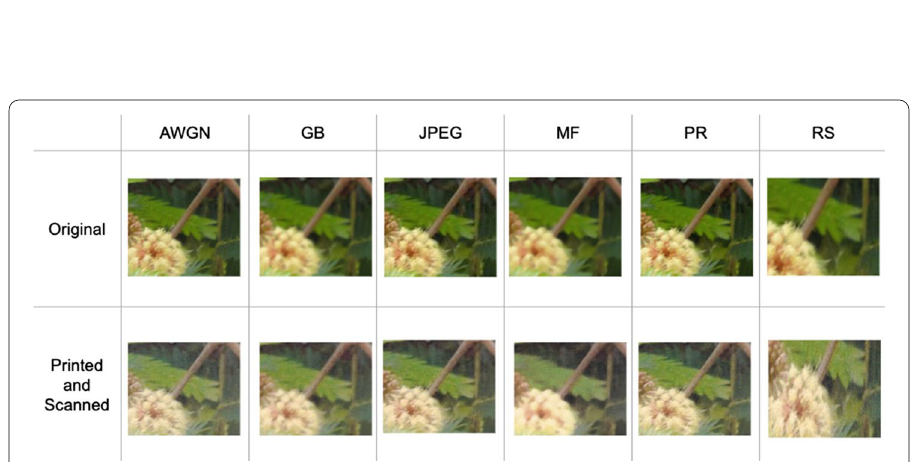
Fig. 3 Examples of manipulations before and after printing and scanning. The six manipulations refer to Additive White Gaussian Noise (AWGN), Gaussian blurring (GB), JPEG compression (JPEG), median filtering (MF), Pristine or no manipulation (PR) and bilinear resampling (RS). We note that due to the algorithms employed, JPEG compression and resampling might be reasonably similar to the printing and